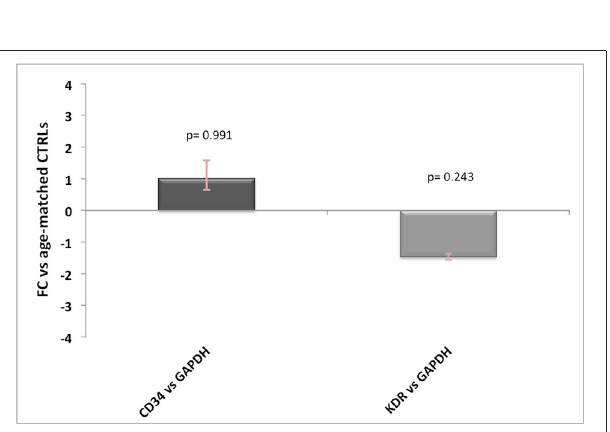
FIGURE 2 | Blood erythrocyte markers expression across controls and patients. Absolute C T -values for ALAS2 in control and neurodegenerative affected brain samples. “Blood contaminated” samples are shown in red. Pool of blood cDNA ( n = 2) is used as positive control (in red).